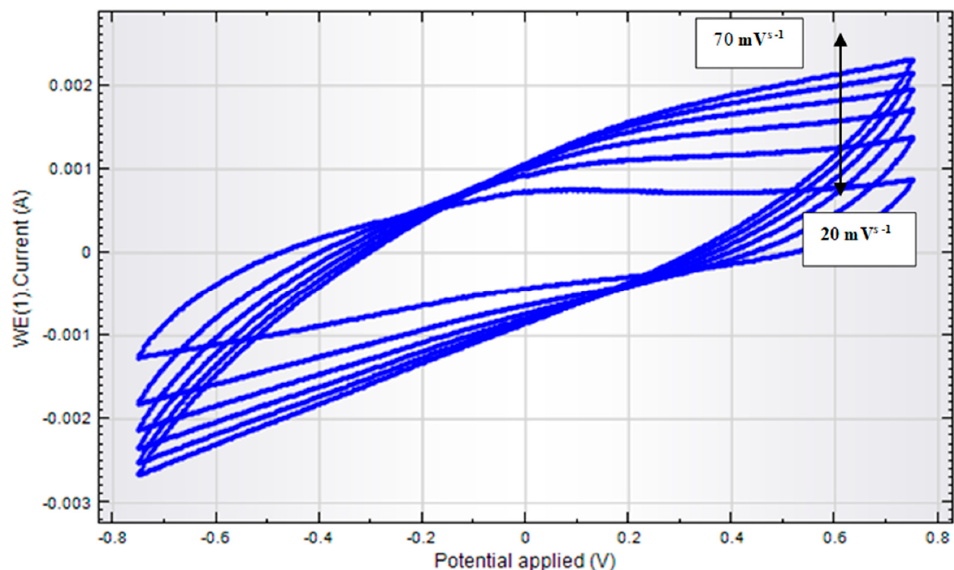
Figure 8. Cyclic voltammetry study of AChENPs/ChONPs/GONS/PtNPs/PGE at different scan rates for 0.1 M acetylcholine from ( a ) 20 mV s − 1 , ( b ) 30 mV s − 1 , ( c ) 40 mV s − 1 , ( d ) 50 mV s − 1 , ( e ) 60 mVs − 1 and ( f ) 70 mVs − 1 . Eap = − 0.8 to +0.8 V. (AChENPs = Acetylcholine esterase nanoparticles; ChONPs = Choline